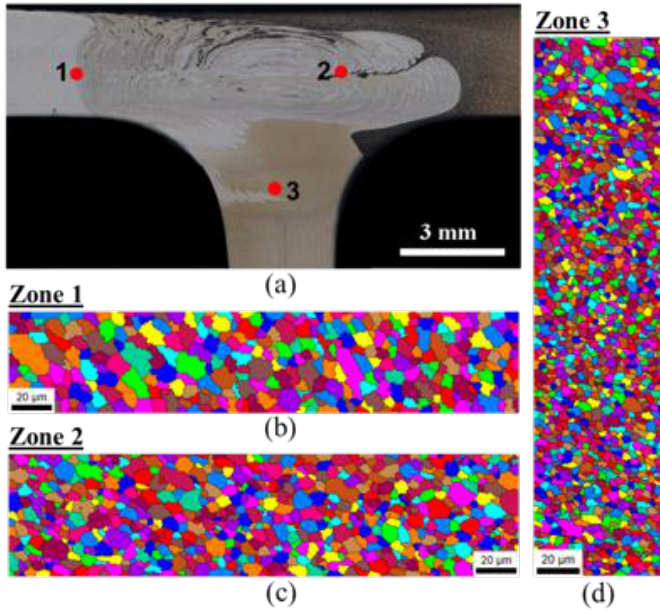
Figure 9. Electron backscatter electron backscatter diffraction (EBSD) analysis conducted for the 562-120 weld: ( a ) zones analyzed and EBSD maps registered in zones 1 ( b ), 2 ( c ), and 3 ( d ).